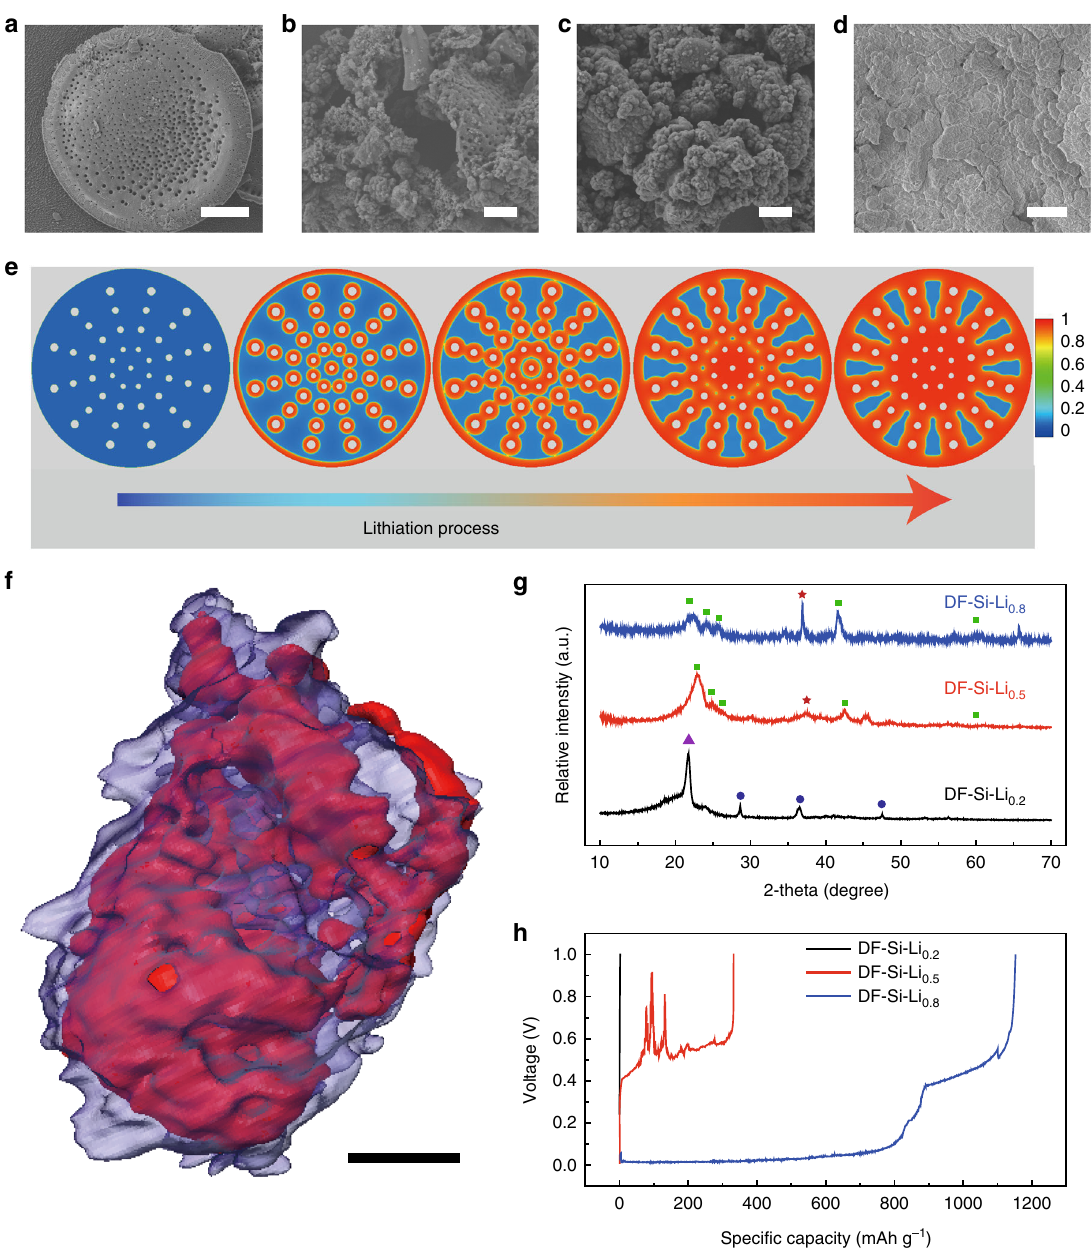
Fig. 3 Characterizations and simulations of DF-Si powder lithiated by different amounts of Li. a – d SEM images of pristine DF-Si, DF-Si-Li 0.2 , DF-Si-Li 0.5 , and DF-Si-Li 0.8 , respectively (scale bar = 10 μ m for Figure a, scale bar = 5 μ m for Figure b , c , d ). e The simulation of Li diffusion into the DF-Si framework during the lithiation process. The variation from the blue color to red color represents the increase of Li concentration and lithiation extent of DF-Si along with the lithiation process. f SXT image of the DF-Si-Li 0.8 microparticle (scale bar = 1 μ m). The image was rendered based on the difference of X-ray adsorption. The red color represents Li 4.4 Si, while blue color corresponds to Li. g PXRD patterns of DF-Si lithiated with different amounts of Li. With a higher Li/DF-Si mass ratio, the relative intensity of the metallic peak (red asterisk) became more signi fi cant. The blue triangle denotes the peak of sample pack, the blue cycles denote the peaks of Si, and the green squares denote the peaks of Li 4.4 Si. h Li- stripping voltage plateau curves of different DF-Si – Li